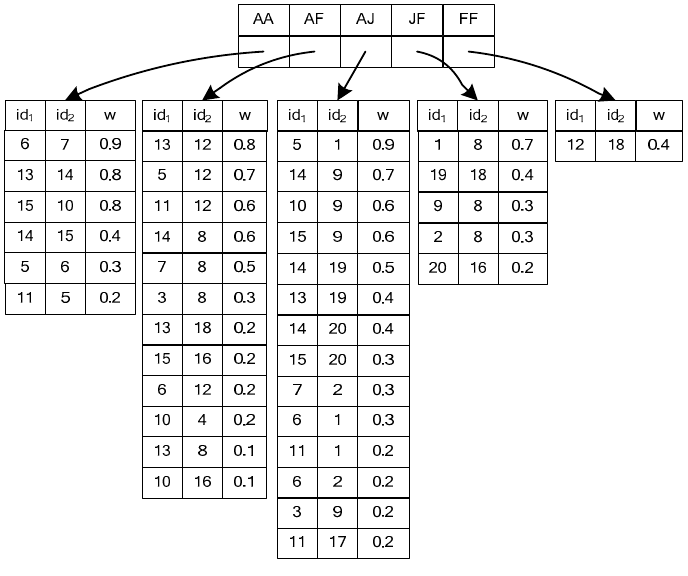
Figure 4. Edge feature (EF) index for G in Figure 1.